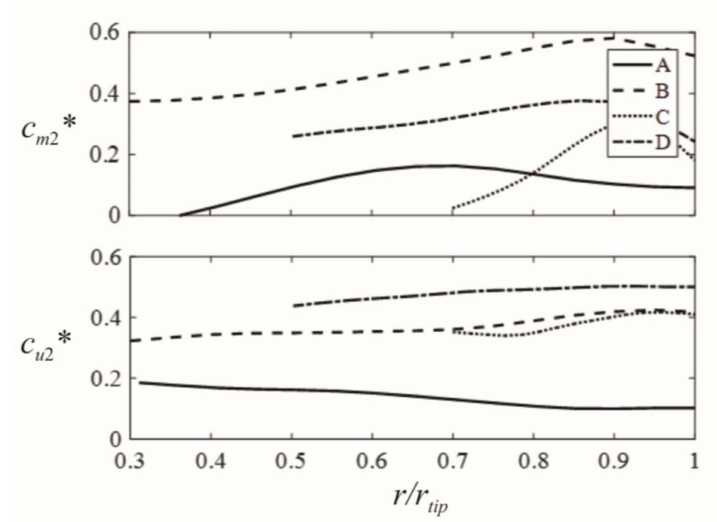
Figure 7. Distributions of the meridional (throughflow) and tangential flow velocities in the impeller exit plane; the velocities are normalized with the blade tip speed π D tip n , indicated by the star as a